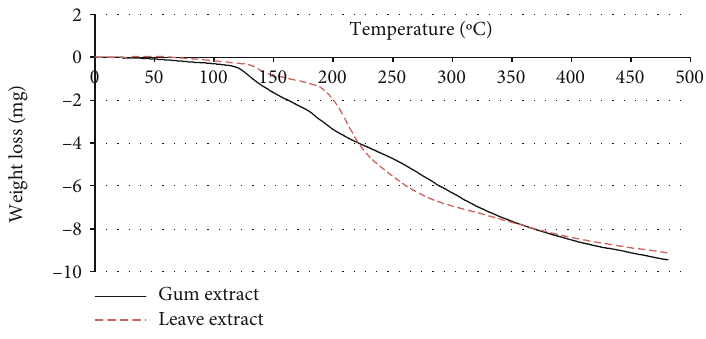
Figure 3: TGA thermograms of leaf and gum